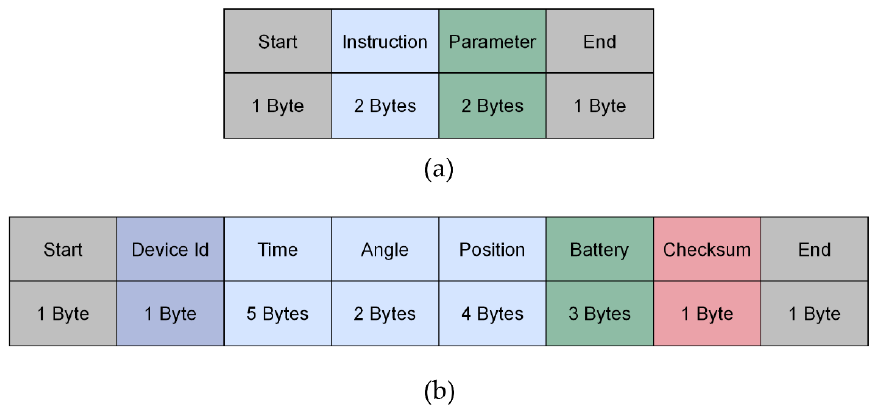
Figure 4. The format of the message frame: ( a ) request frame; ( b ) response frame.